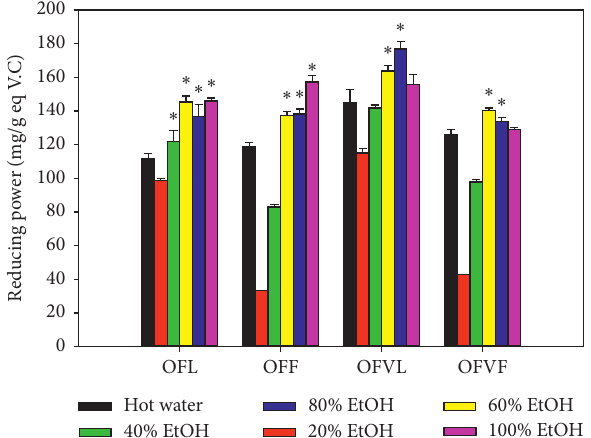
Figure 5: Reducing power of various extracts of Osmanthus fra- grans ( n � 3; ∗ significantly higher than the “hot water” extract).